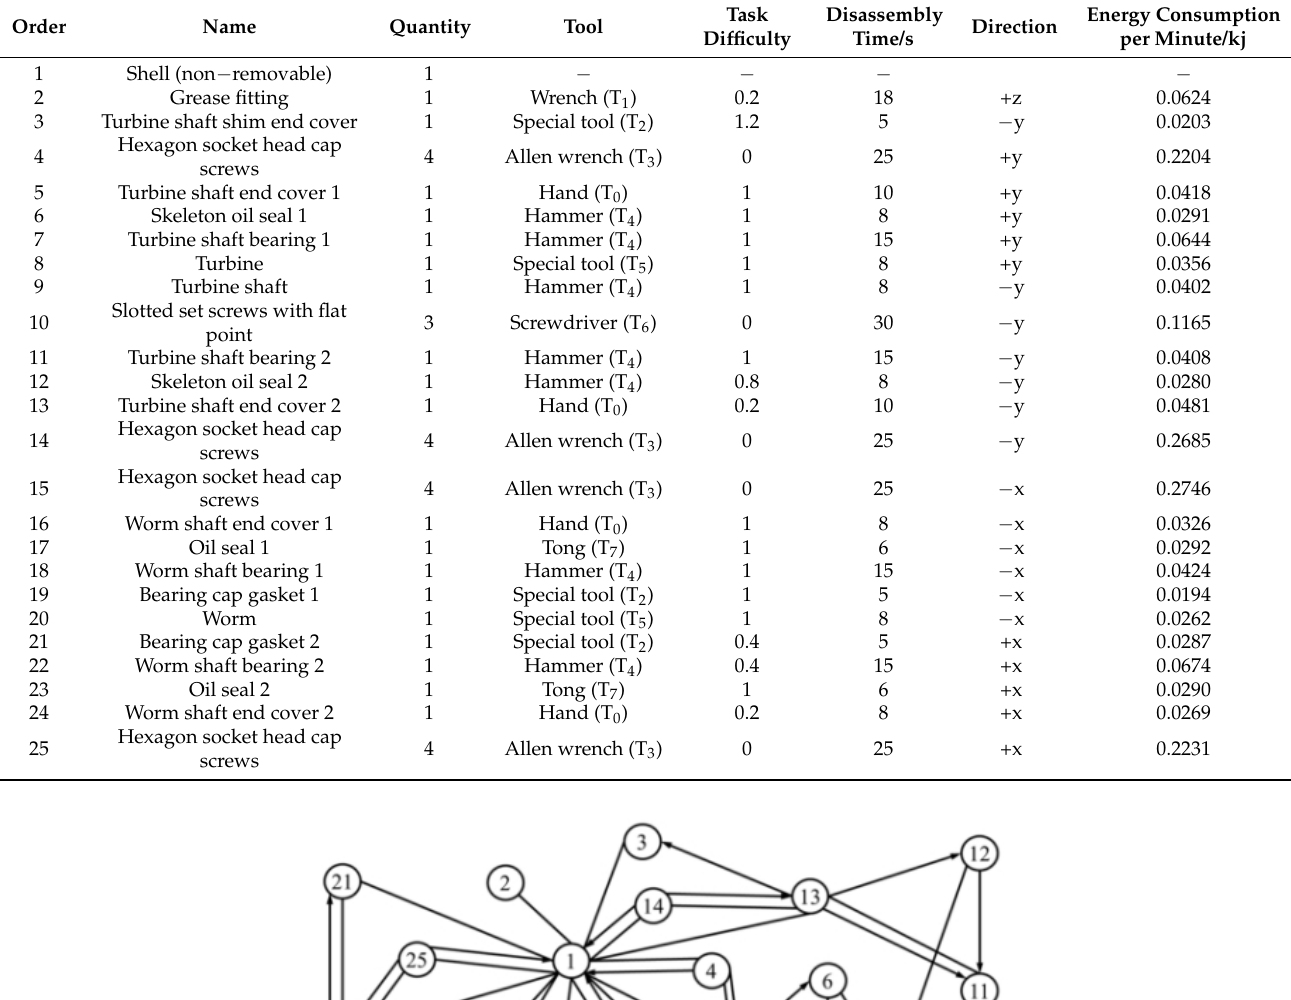
Table 1. Parts of worm reducer.